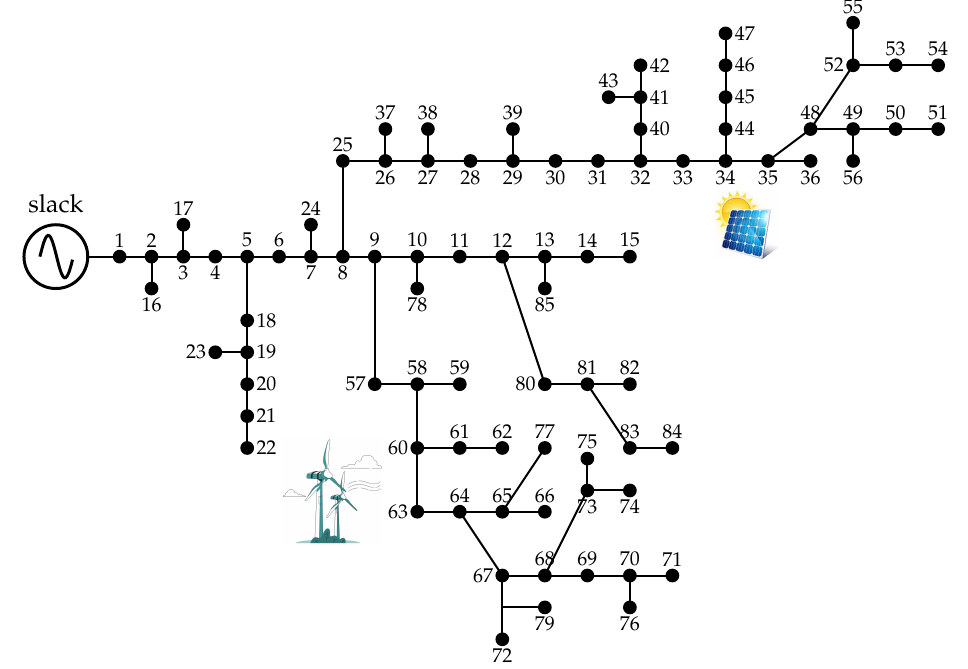
Figure 13. Single-line diagram for the IEEE 85-bus